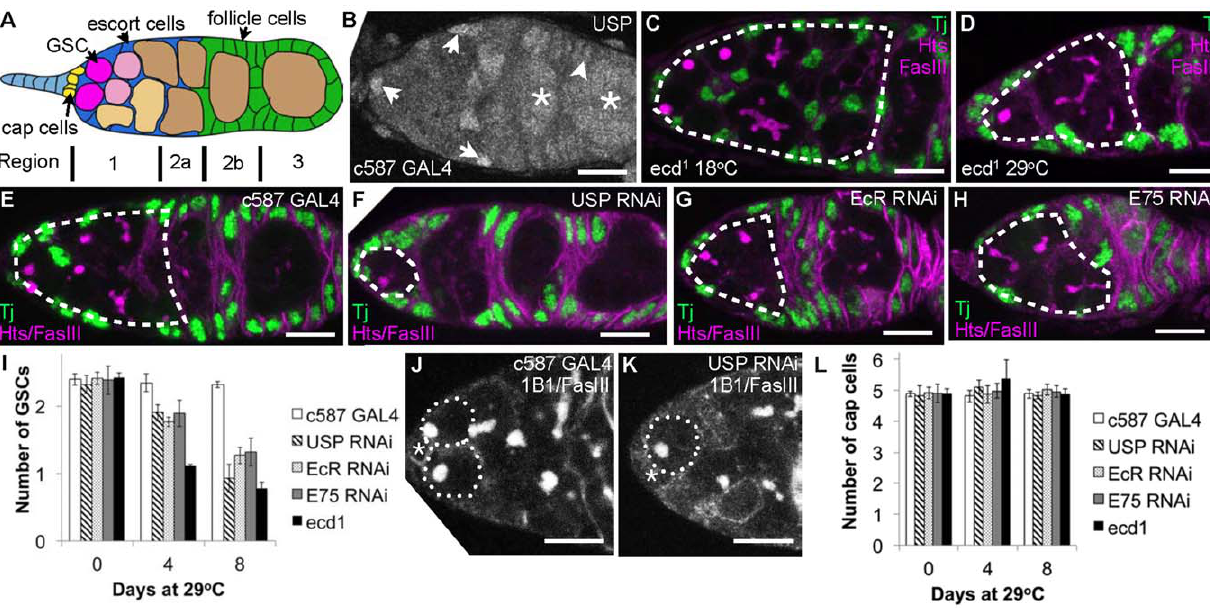
Figure 1. Ecdysone signaling maintains germarial size and GSC number. A) Diagram of the Drosophila germarium: terminal filament cells (light blue), cap cells (yellow), GSCs (magenta), cystoblasts (pink), cysts (beige), escort cells (dark blue), follicle cells (green). Subregions 1–3 of the germarium are indicated. B) anti-USP staining of somatic escort cell nuclei (arrows), follicle cell nuclei (arrowhead) and germ cells within forming follicles (asterisks). C–H) Regions 1 and 2a of the germaria containing GSCs and cysts (dashed outline) appear smaller when ecdysteroid signaling is reduced. C) ecd 1 18 o C control; D) ecd 1 29 o C day 4; E) c587 alone 29 o C day 8; F) c587::USP RNAi 29 o C day 8; G) c587::EcR RNAi 29 o C day 8; H) c587::E75 RNAi 29 o C day 8. Green, somatic cells (anti-Tj), magenta, cell membranes and spectrosome/fusome (anti-Hts and anti-FasIII). I) Time course showing the number of GSCs present in germaria from controls and flies in which ecdysone signaling was reduced for the duration shown as described. J-K) Control germaria usual have two to three GSCs (J, dashed outline), whereas c587:USP RNAi flies after 8 days at 29 u C usually have only one (K, dashed outline), white: cell membranes and spectrosome/fusome (anti-Hts and anti-FasIII). Asterisk marks the position of the cap cells. L) The number of cap cells was counted in germaria from controls and flies in which ecdysone signaling was reduced for the duration shown. Cap cell number is not affected by reducing ecdysteroid signaling. Error bars indicate s.d. Scale bar: 10 m m.